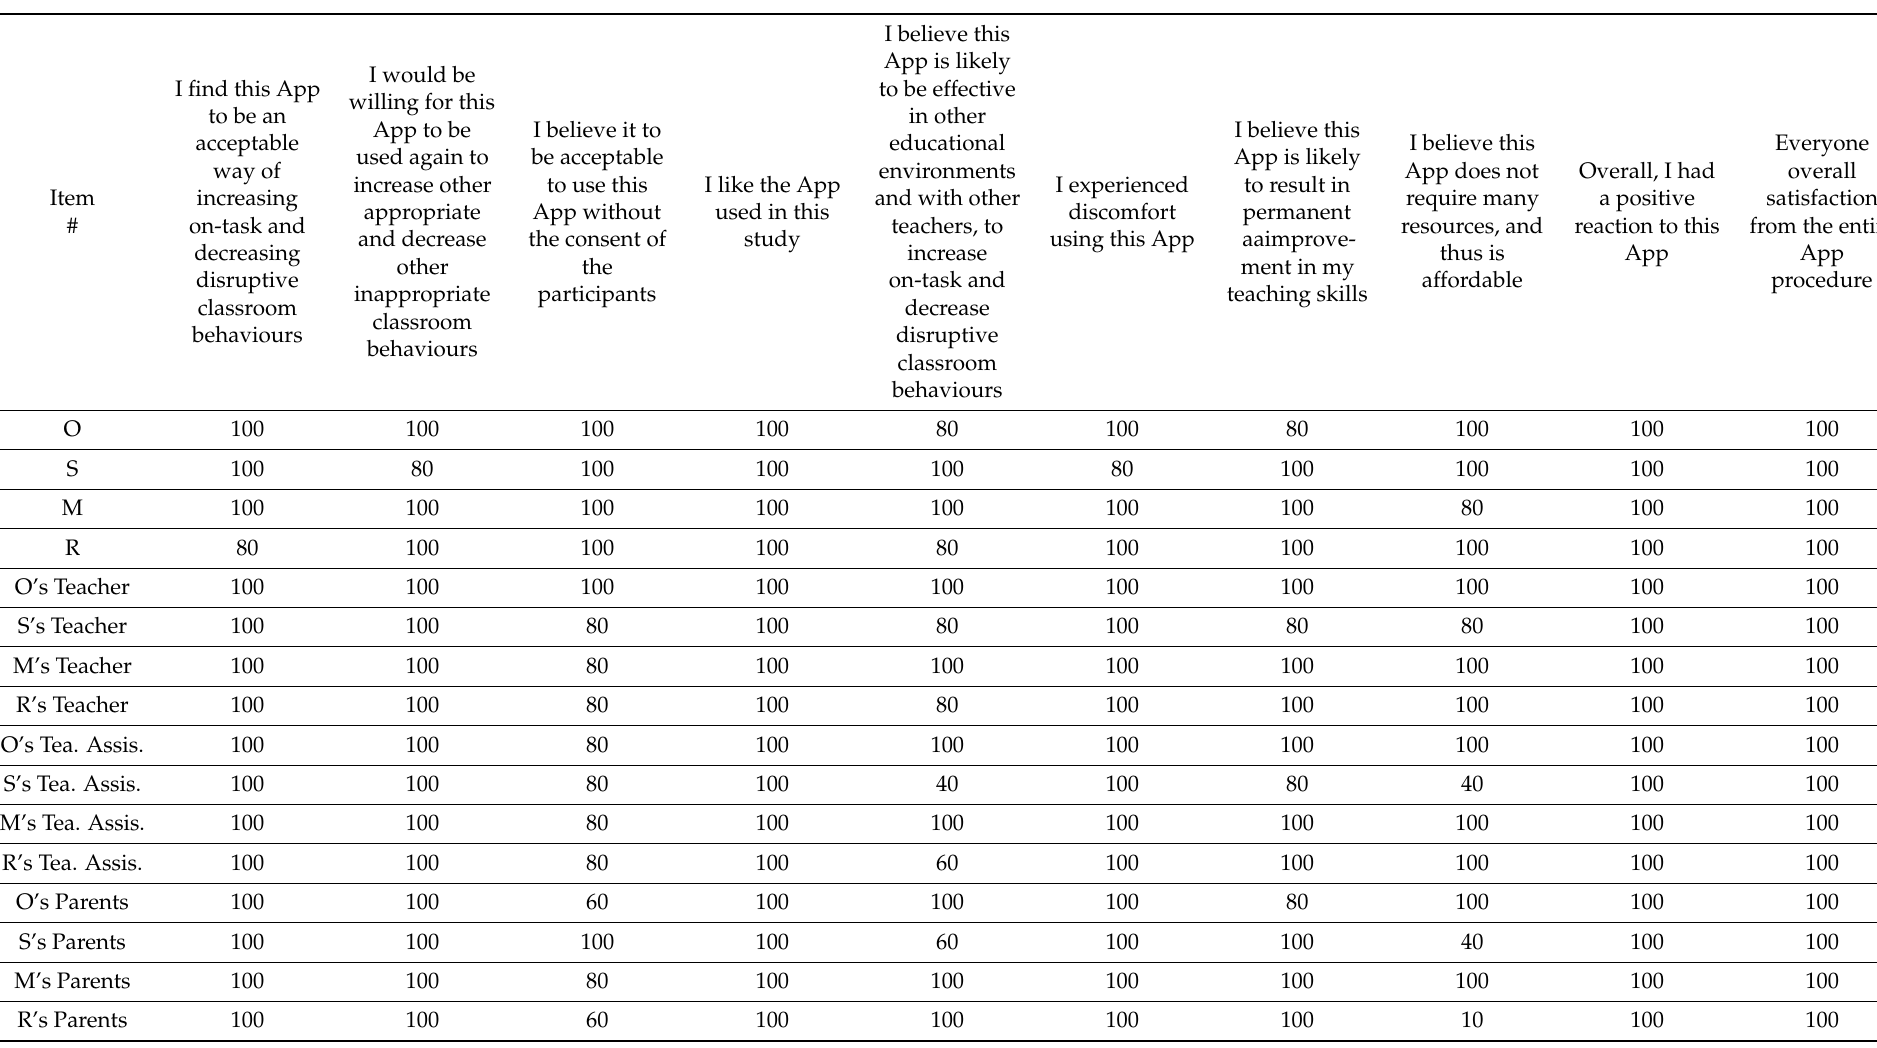
Table 3. Participants’, teachers’, teaching assistants’ and parents’ responses to the use of the